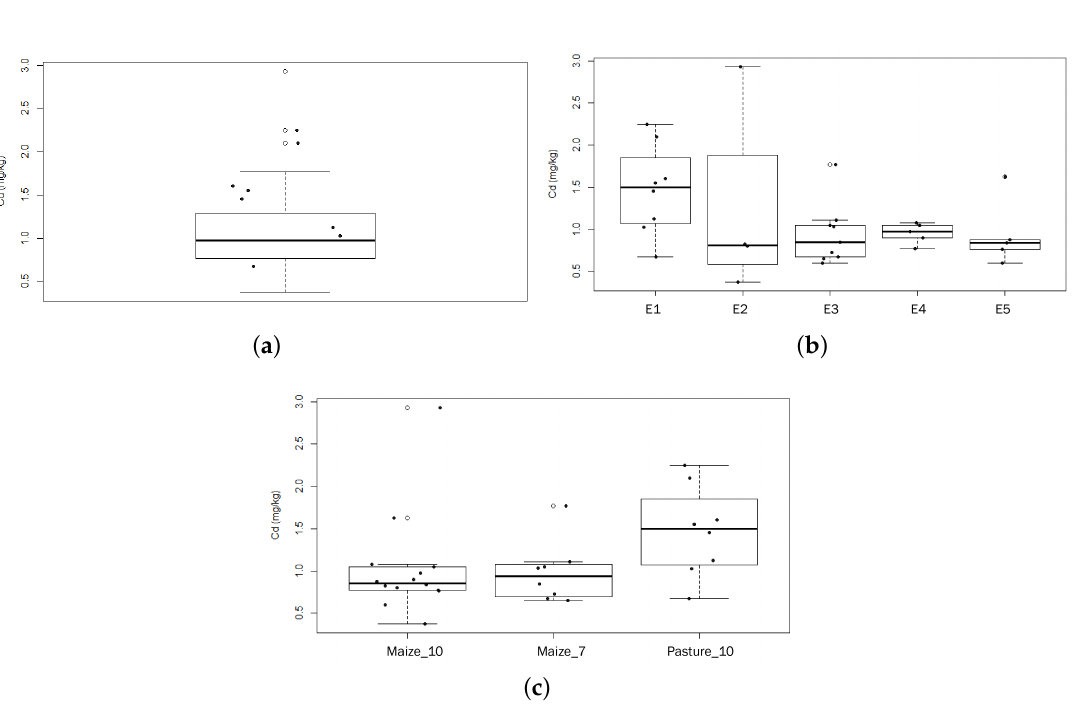
Figure 4. Cadmium content in soil: ( a ) cocoa crops; ( b ) sectors; ( c ) prior exploitation of